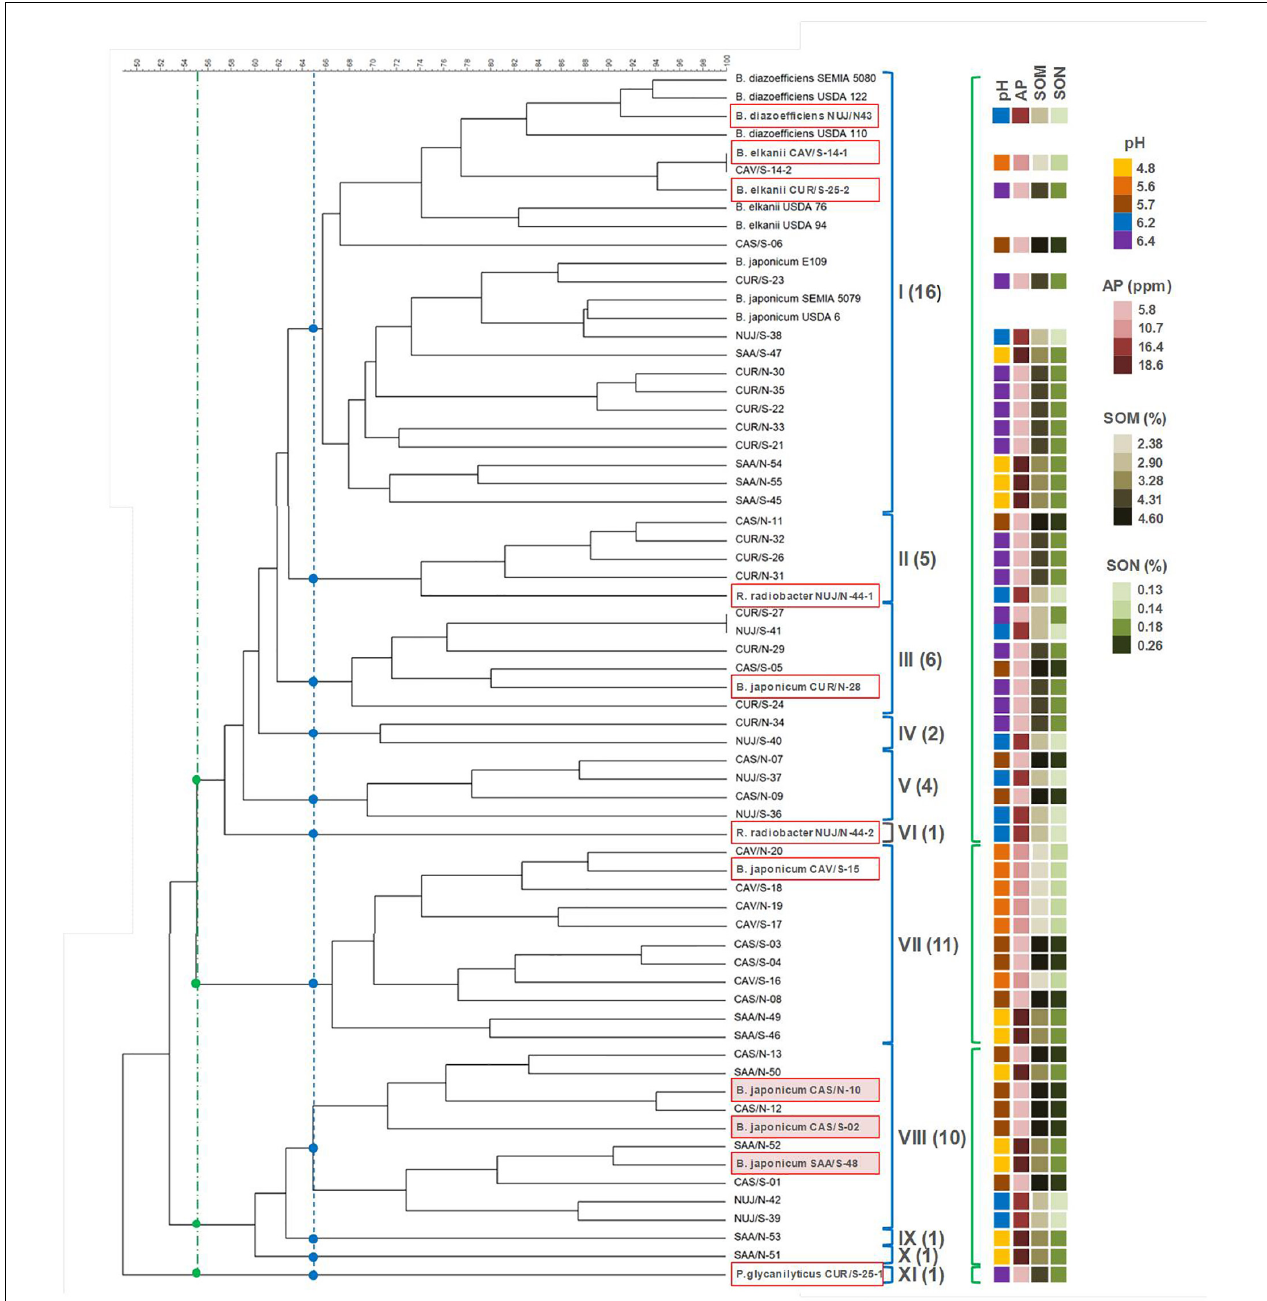
FIGURE 1 | DNA-fingerprint of the SNAP-isolates and reference strains obtained with BOX-A1R primer. Clades were defined at 65% similarity (blue lines, dots, and brackets) or 55% similarity (green lines, dots, and brackets). The numbers of SNAP-isolates included in clades I–XI (at 65% similarity) are indicated in parenthesis. Boxed isolates are those picked for further species identification and characterization. Shadowed boxes indicate isolates that were equally competitive as the reference strain B. japonicum E109. Relevant soil properties of the soil of origin of each SNAP isolate are shown as colored squares on the right, according to the color scale for the values of soil properties detailed in Table 1 . AP, available phosphorous; SOM, soil organic matter; SON, soil organic